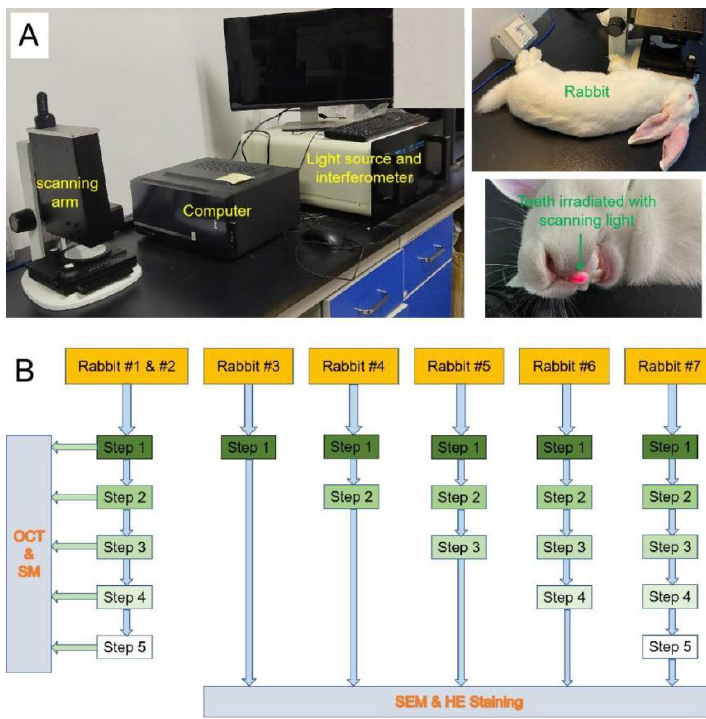
Figure 1. ( A ) The OCT system and a fixed rabbit, which teeth was irradiated with scanning light. ( B ) The schematic diagram of the protocol of this study. ( B ) The schematic diagram of the protocol of this